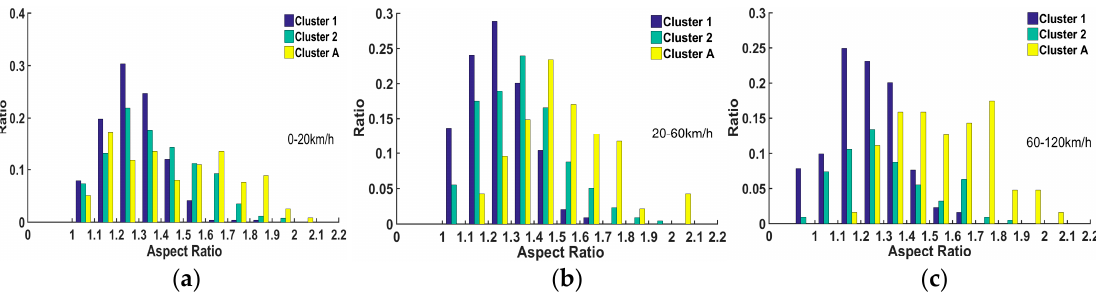
Figure 7. Proportion of vehicle aspect ratios in clusters 1, 2, and A at different speed stages: ( a ) 0–20 km/h; ( b ) 20–60 km/h; and ( c ) 60–120